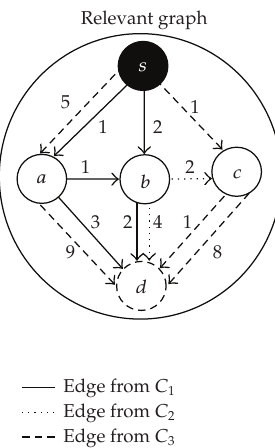
Figure 2: Relevant graph calculated for the transfer graph in Figure